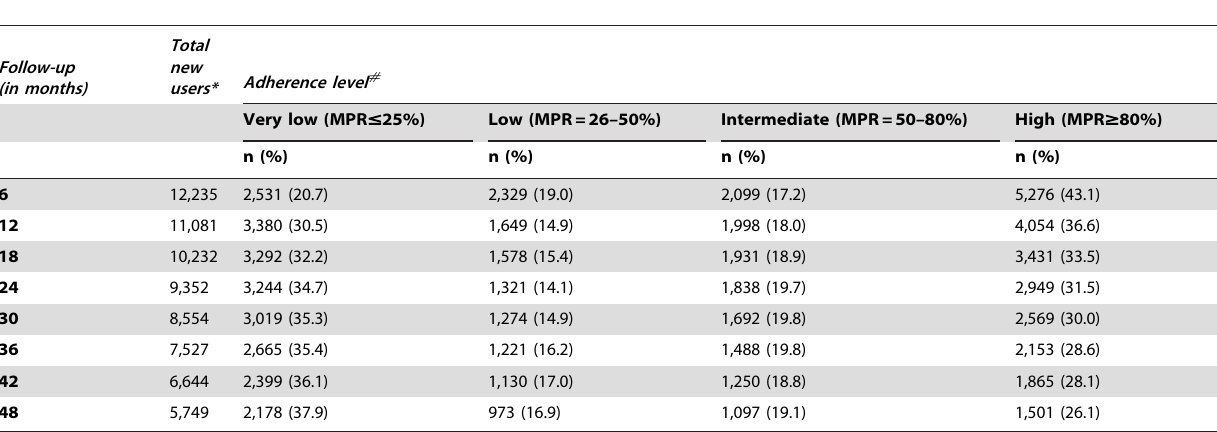
Table 2. Adherence level to new treatment with any statin at different time period of follow-up.